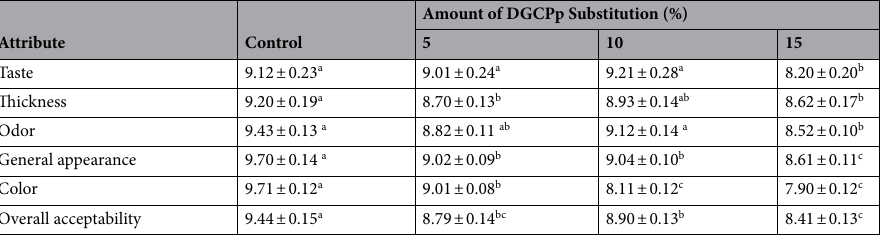
Table 7. Sensory quality attributes of the instant DGCPp soup. Data are expressed as mean ± SD. Mean values with different superscript letters [a (the highest values)—c (the lowest value)] in the same row are significantly different at ( p ≤ 0.05). All groups were compared to each